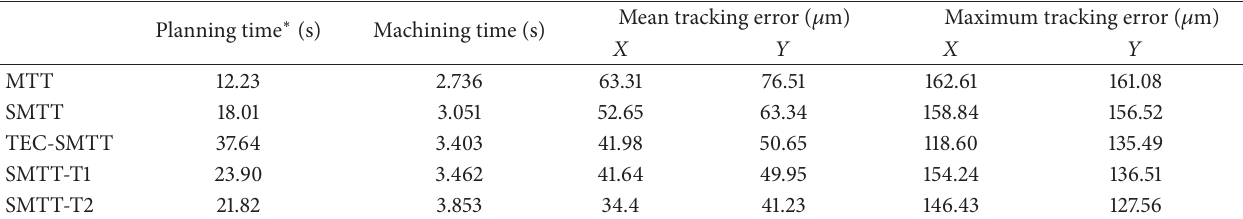
Figure 13: Simulated execution acceleration curves of the (a) SMTT and (b) TEC-SMTT commands. Table 2: Performance comparison among MTT, SMTT, and TEC-SMMT for the butterfly